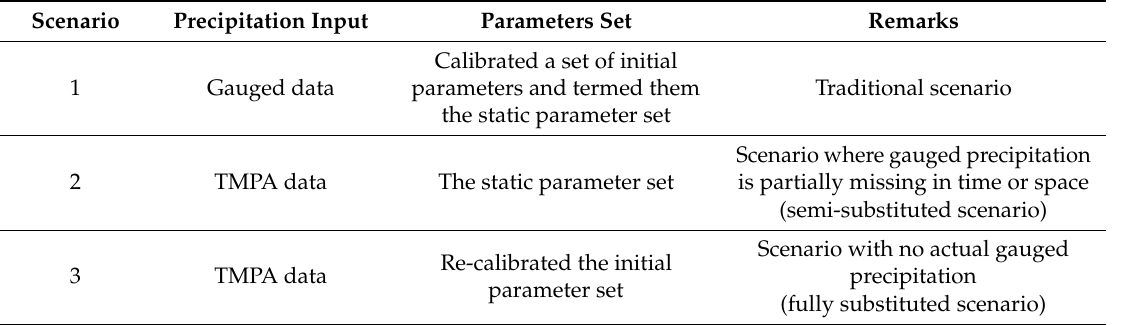
Table 3. Scenario